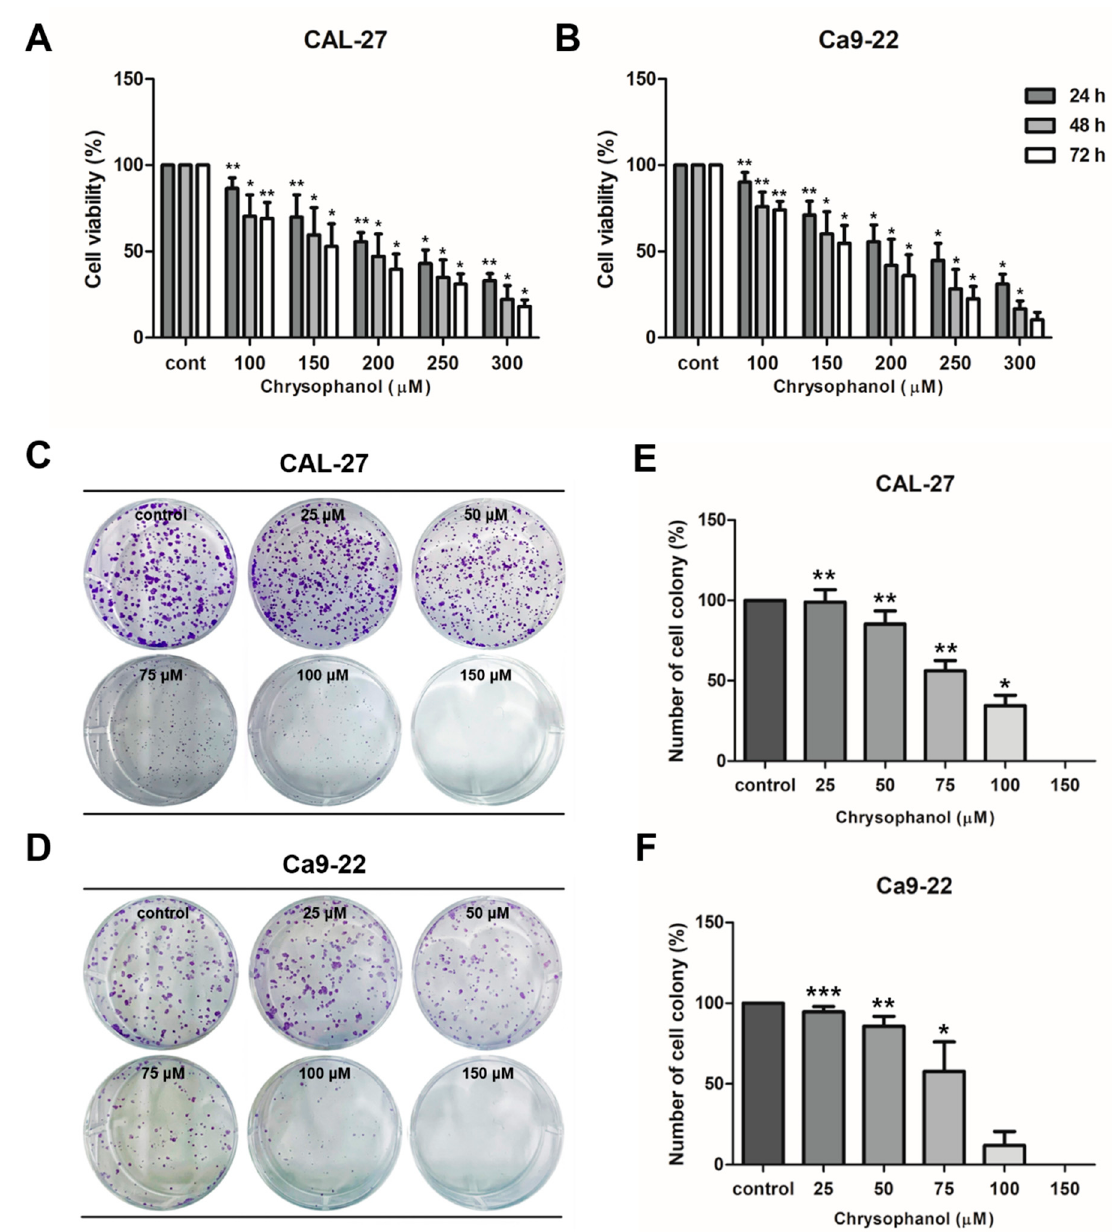
Figure 2. Chrysophanol reduced cell viability and proliferation in CAL-27 and Ca9-22 cells. (A,B) Both cells were incubated with several concentrations of chrysophanol for 24 to 72 h (0–300 µ M), and then the viability of cells was measured using the MTT assay. ( C – F )) A colony-formation assay was performed to examine cell proliferation. Cells were treated with chrysophanol for seven days and stained with a 1% crystal violet solution. The number of colonies was converted into a percentage and shown in a histogram. The results are exhibited as mean ± SD (* p < 0.05, ** p < 0.01, *** p < 0.001).